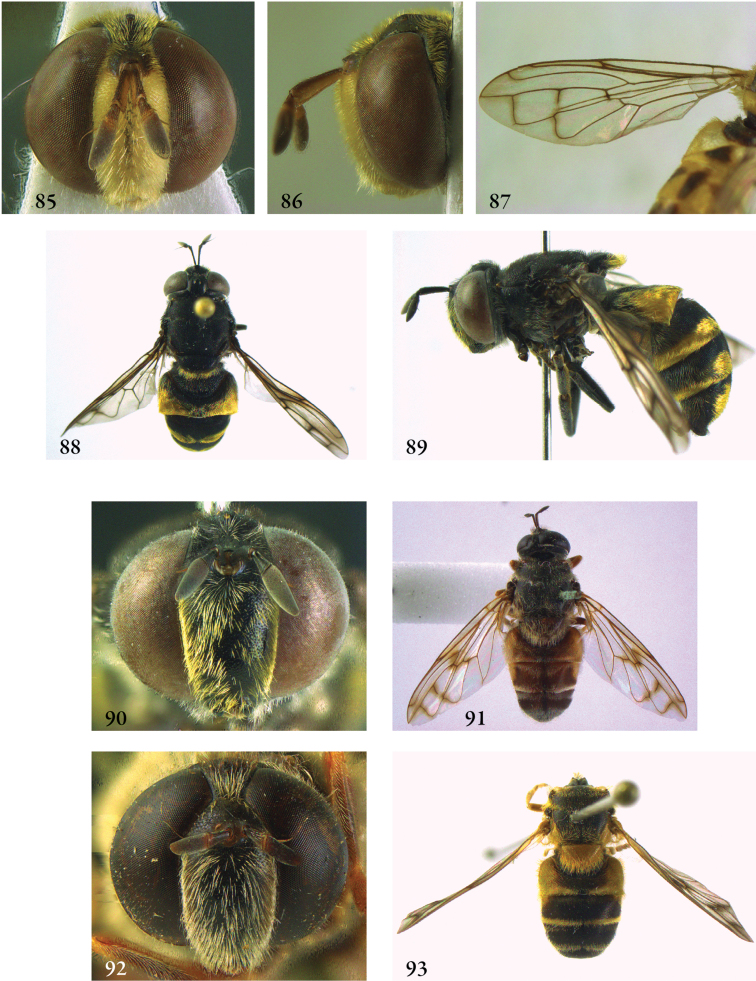
85–87
Heliodon doris male (holotype): 85 head frontal 86 head lateral 87 wing 88–90 Heliodon elisabethanna female (holotype): 88 habitus dorsal 89 habitus lateral 90 head frontal 91–92
Heliodon tiber male (holotype): 91 habitus dorsal 92 head frontal 93
Heliodon tiber female (paratype), habitus dorsal.